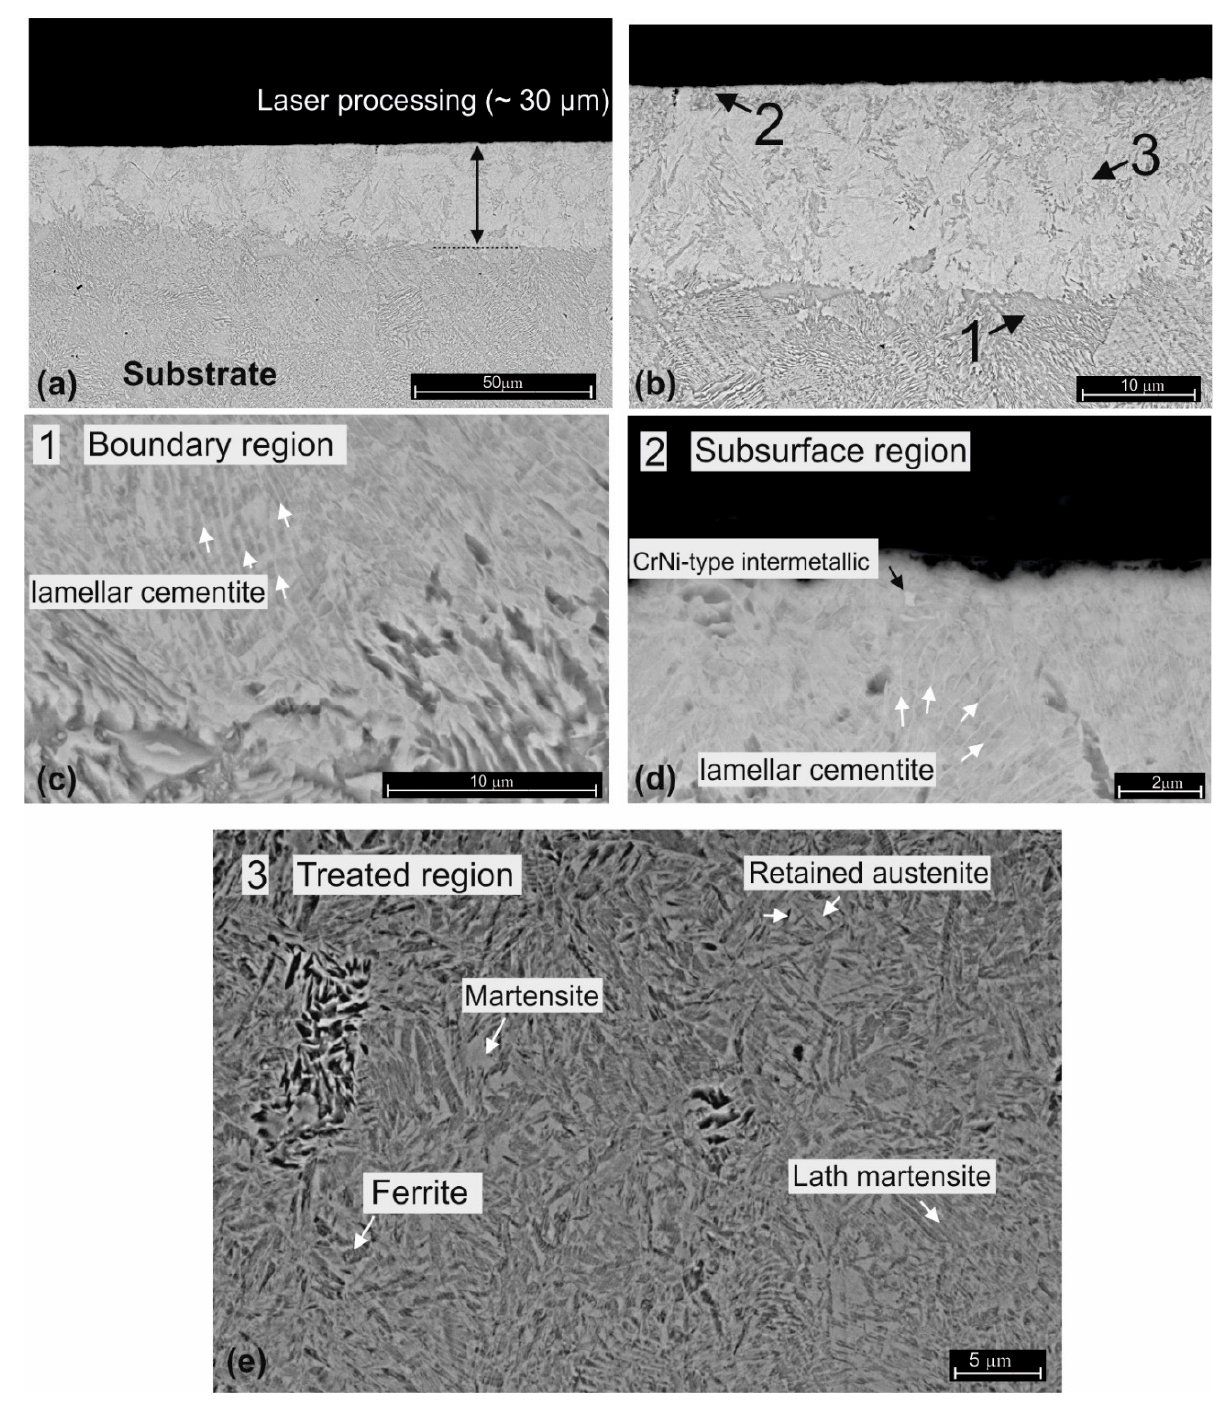
Figure 8. SEM micrographs of the specimen cross section; ( a , b ) laser treated region at different magnifications; ( c ) boundary between treated–untreated region; ( d ) subsurface region and ( e ) detail on the treated region (aqua regia etching).